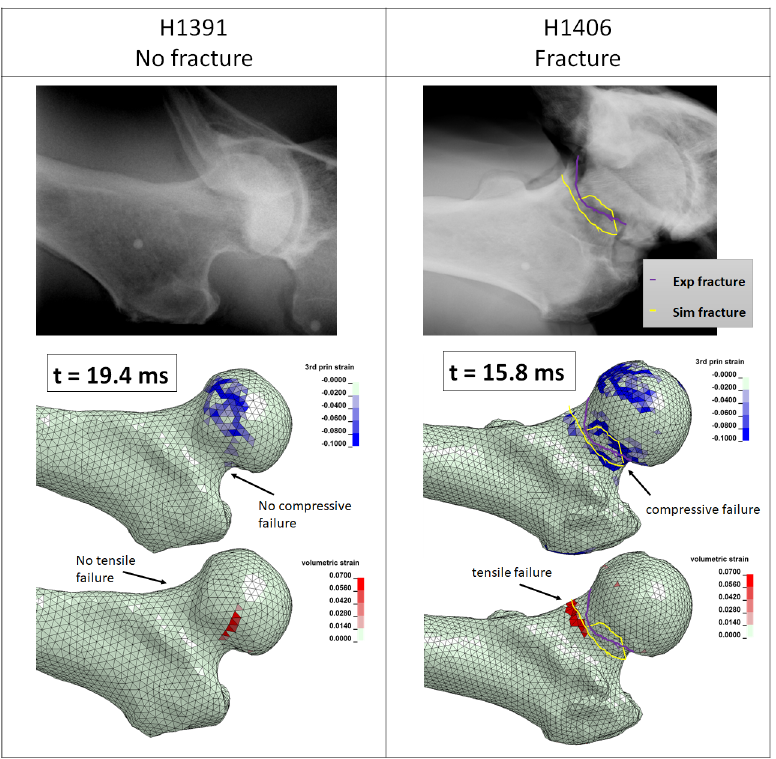
Fig 10. FEM based fracture prediction based on surface strain patterns as per simulation results 2 ms after the time of experimentally measured peak impact force. Experimental fracture line marked in purple and FE predicted fracture line marked in yellow. Top row: Post-testing X-rays. Middle row: FEM derived 3rd principal strain component of the St.Vernant-Green strain tensor. Bottom row: FEM derived 1st principal strain component of the St. Vernant-Green strain